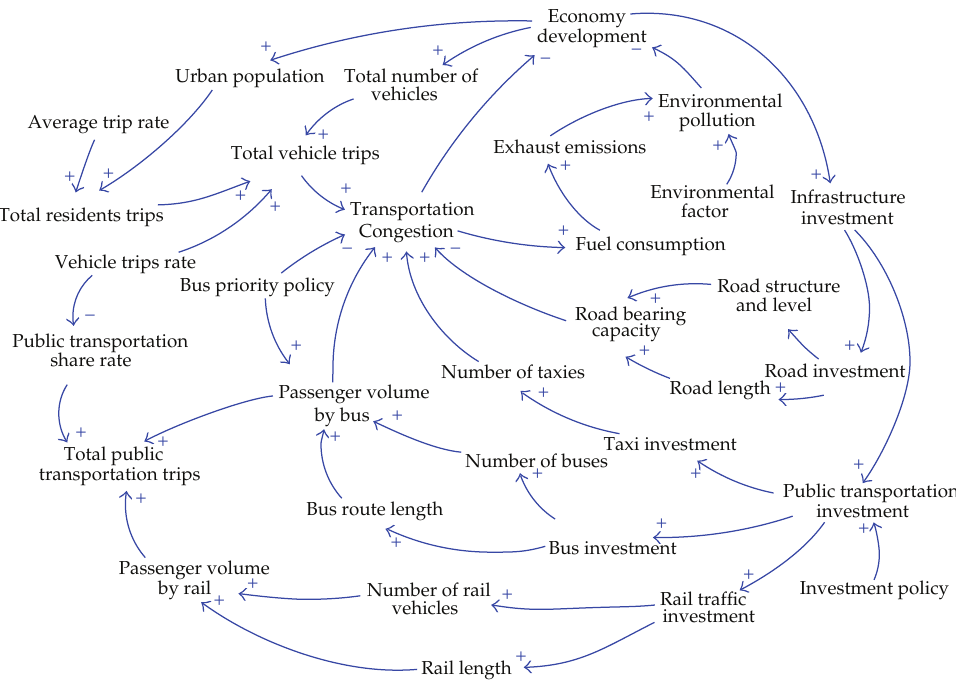
Figure 3: The cause-e ff ect relationship diagram of garden city transportation